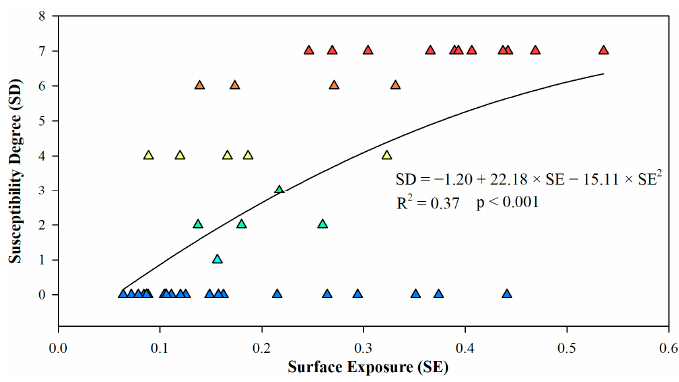
Figure 14. Relationships between SEs and SDs. SEs represent the land surface exposure, which are calculated quantitative values. SDs are the susceptibility level defined by us, which can be considered as semi-quantitative values. We use different colors to distinguish the different types of debris flow gully. According to the regression equation, with the increase in SE, the SDs of debris flow gullies show an increasing trend, indicating that the gully is more likely to suffer from debris flows. The R 2 of the fitting model of SEs and SDs is 0.37, with p < 0.001. Since there are no continuous values on the axes, it is not ruled out that there is a better fitting equation.